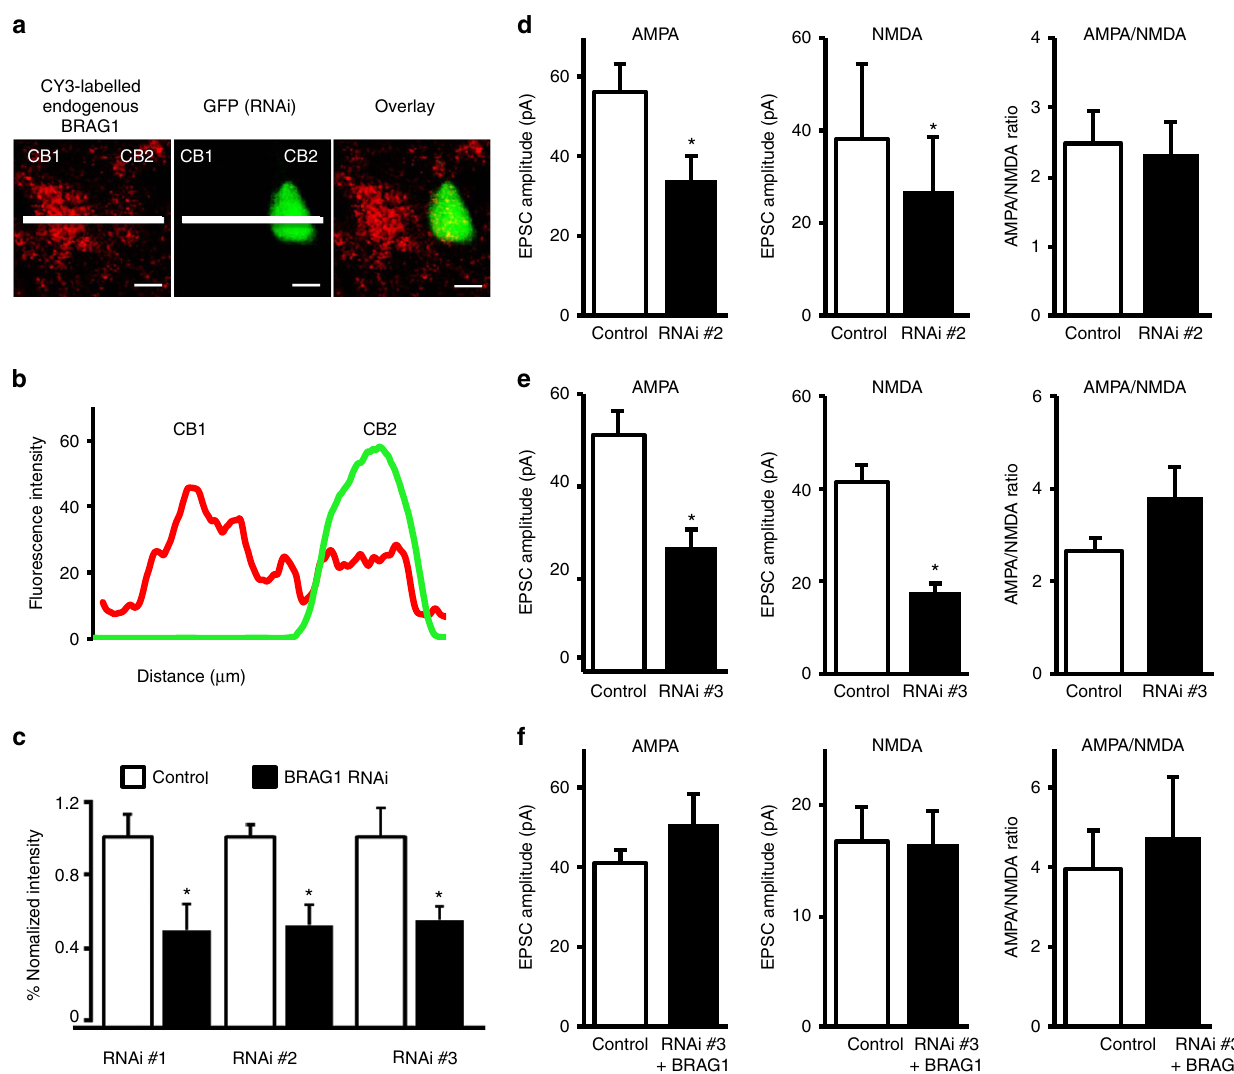
Figure 7 | BRAG1 is required for the maintenance of synaptic transmission. ( a ) Representative confocal images from organotypic hippocampal slices transfected with pSuper plasmid containing BRAG1-siRNA and expressing GFP (to visualize the transfected cells) and immunostained 2 days later for BRAG1 (red signal) under permeabilized conditions. Note, the cell transfected with the BRAG1-siRNA (green cell) has low levels of endogenous BRAG1 (red signal). Scale bars, 10 m m. ( b ) Representative line plot analysis of BRAG1 (red signal) and GFP (green signal). CB1 is a cell body of non-transfected neuron; CB2 is that of a transfected neuron. ( c ) Normalized intensity from the line plots for endogenous BRAG1 for the three different RNAi used; RNAi significantly ( P r 0.05) decreased BRAG1 levels. RNAi #1: n ¼ 14, P ¼ 0.0112; RNAi #2: n ¼ 7, P ¼ 0.0132; RNAi #3: n ¼ 10, P ¼ 0.0417. ( d , e ) Simultaneous whole-cell double recordings from nearby pairs of untransfected (control) neurons and those transfected with either BRAG1-siRNA#2 ( d ) or BRAG1-siRNA#3 ( e ). Left graph: comparisons of evoked AMPAR-mediated responses. Right graph: simultaneous recordings of evoked NMDAR-mediated responses ( P ¼ 0.21). ( f ) RNAi #3 was co-expressed with RNAi-resistant WT BRAG1 to restore BRAG1 levels. Data represent average AMPAR